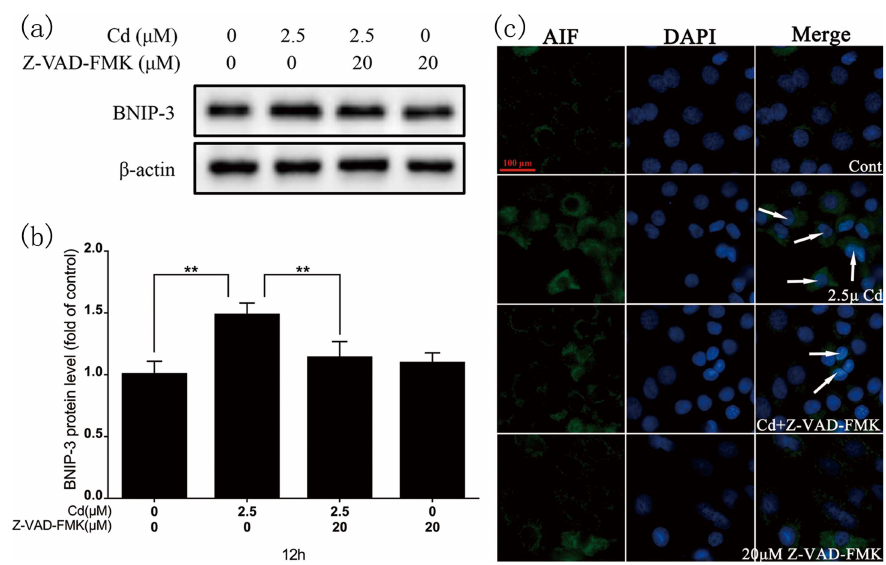
Fig 6. Effect of Z-VAD-FMK on BNIP-3 expression and cytoplasmic AIF translocation to the nucleus after 12-h cadmium treatment. (a) Representative images of BNIP-3 western blot. (b) Quantitative analysis of BNIP-3; grayscaleof the control was set at 1. (c) Twelve-hour cadmiumtreatment with/without Z-VAD-FMK triggeredAIF nucleartranslocation. rPT cells were stained with anti-AIF antibodies and Alexa Fluor 488– labeledgoat anti-rabbit IgG. AIF nuclear translocation was evaluatedunder fluorescence microscopywith DAPI staining. Scale bar: 50 μ m. Results are from three independent experiments (mean ± SD, n = 3). ** P < 0.01 as comparedto control.